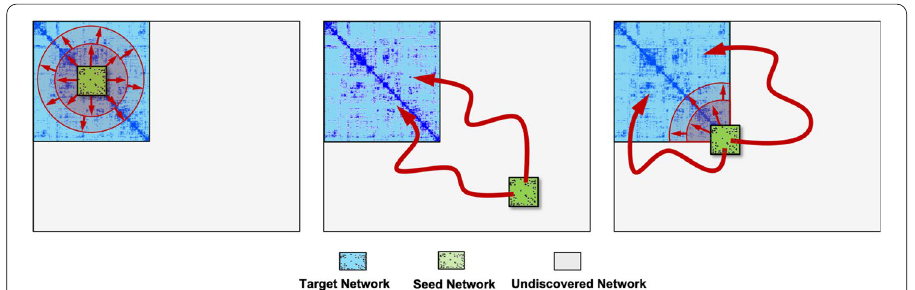
Fig. 3 Representative high level abstractions of network states for selective harvesting